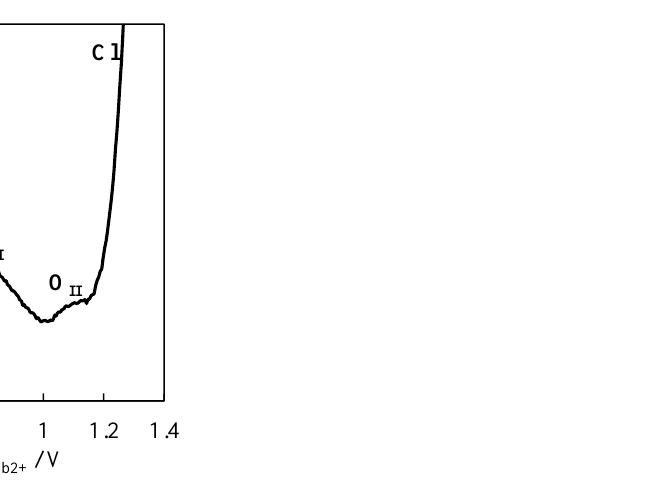
Figure 3. SWV in the initial PbCl 2 melt without the external addition of PbO at a potential reverse frequency of 25 Hz, potential sweep rate of 0.1 V s −1 and a temperature of 520 °C.